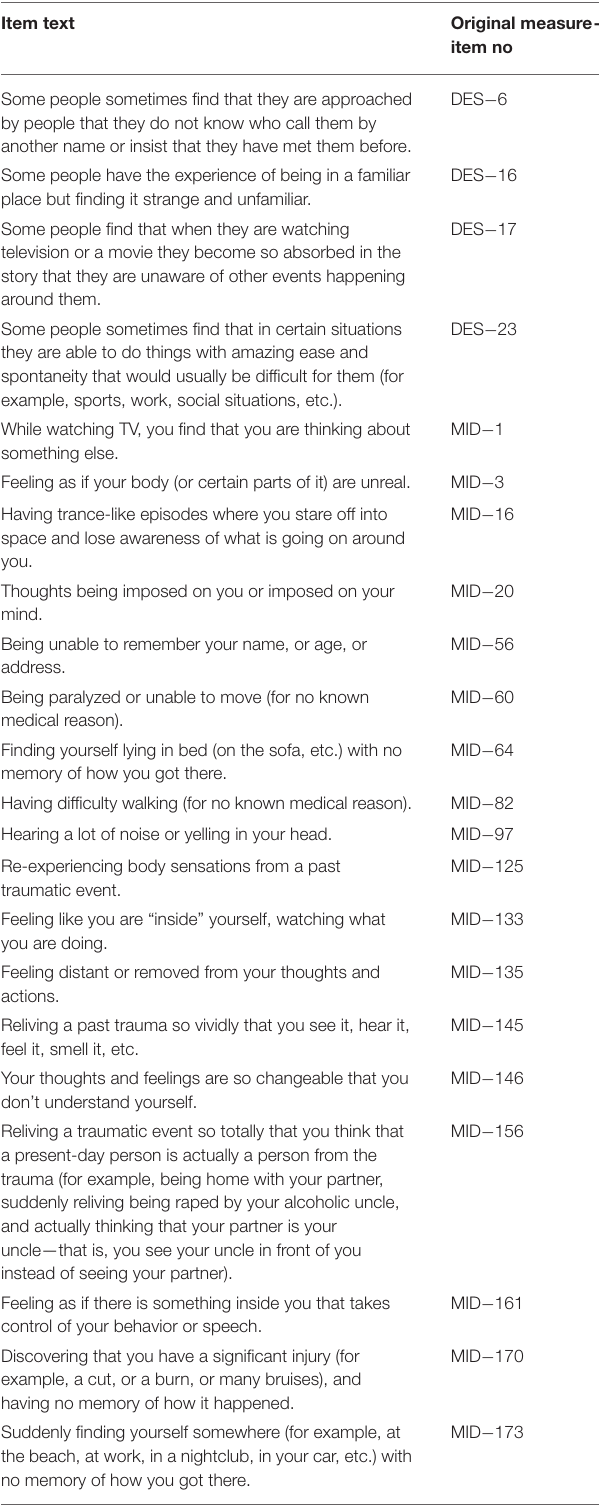
TABLE 5 | Items in the Functional Impairment Prediction Scale derived from clinical and functional impairment measures of outpatients and daycare patients ( N =